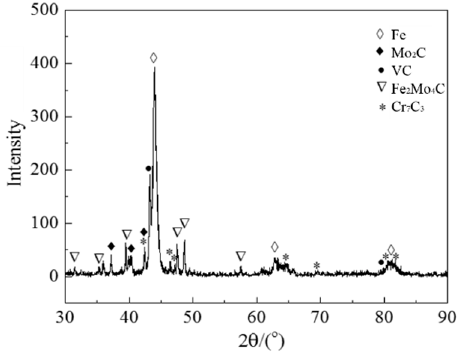
Figure 10. XRD pattern of HSS after solution treatment.